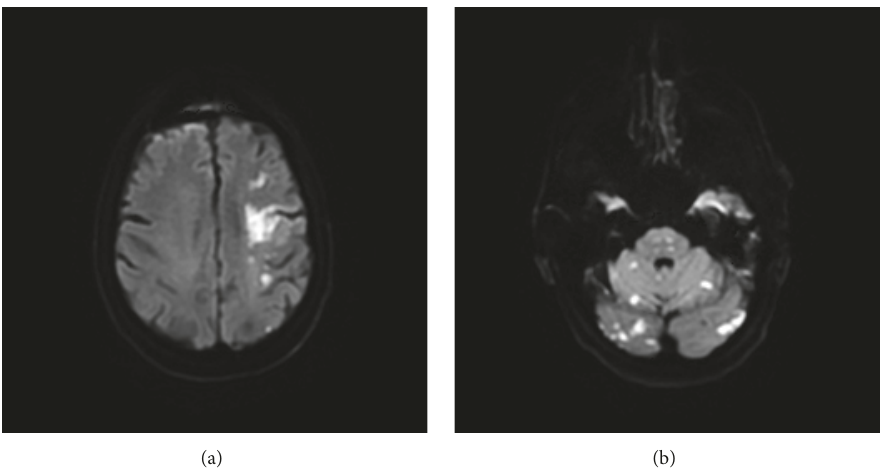
Figure 2: (a) An MRI of the brain revealing areas of restricted diffusion in the left carotid artery distribution. (b) MRI of the brain showing new infarcts in the superior cerebellum and occipital lobe, within the PTA territory.